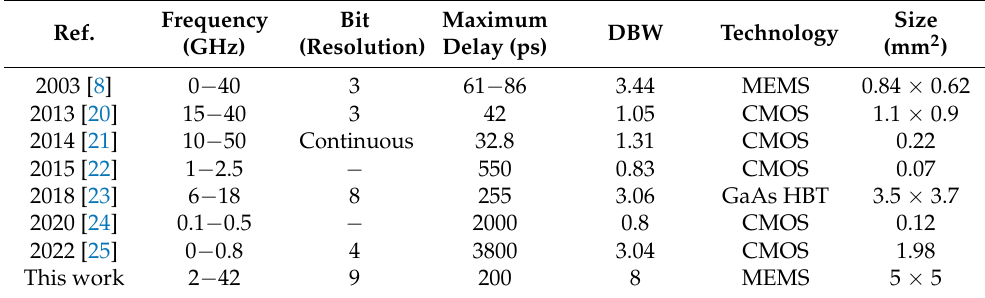
Table 4. Comparison of TTDL